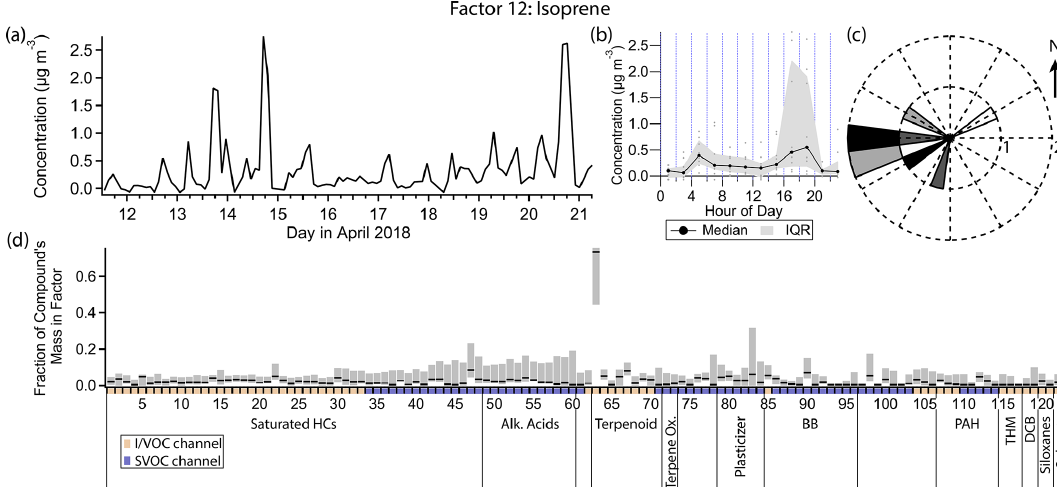
Figure 17. (a) Factor 12 timeline. (b) Diurnal profile for Factor 12. (c) Rose plot showing correlation of elevated emissions and wind direction. (d) Factor 12 composition profile. See Fig. 4 description for further information on how to read this